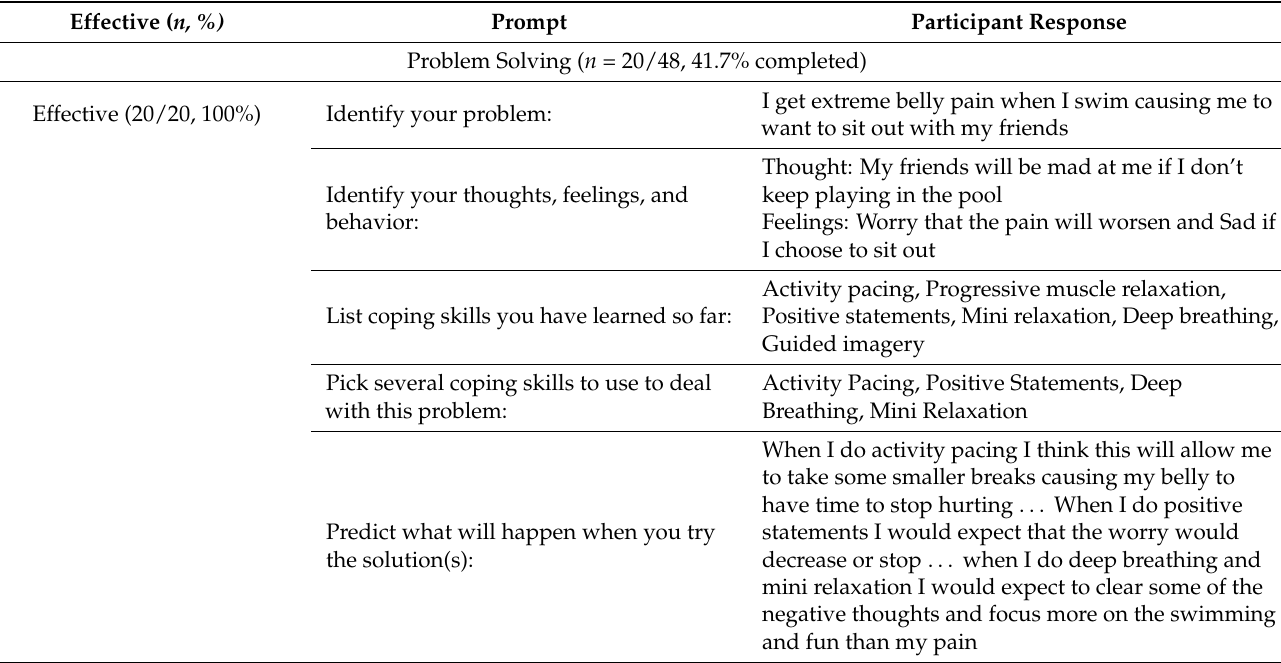
Table 3. Effectiveness of